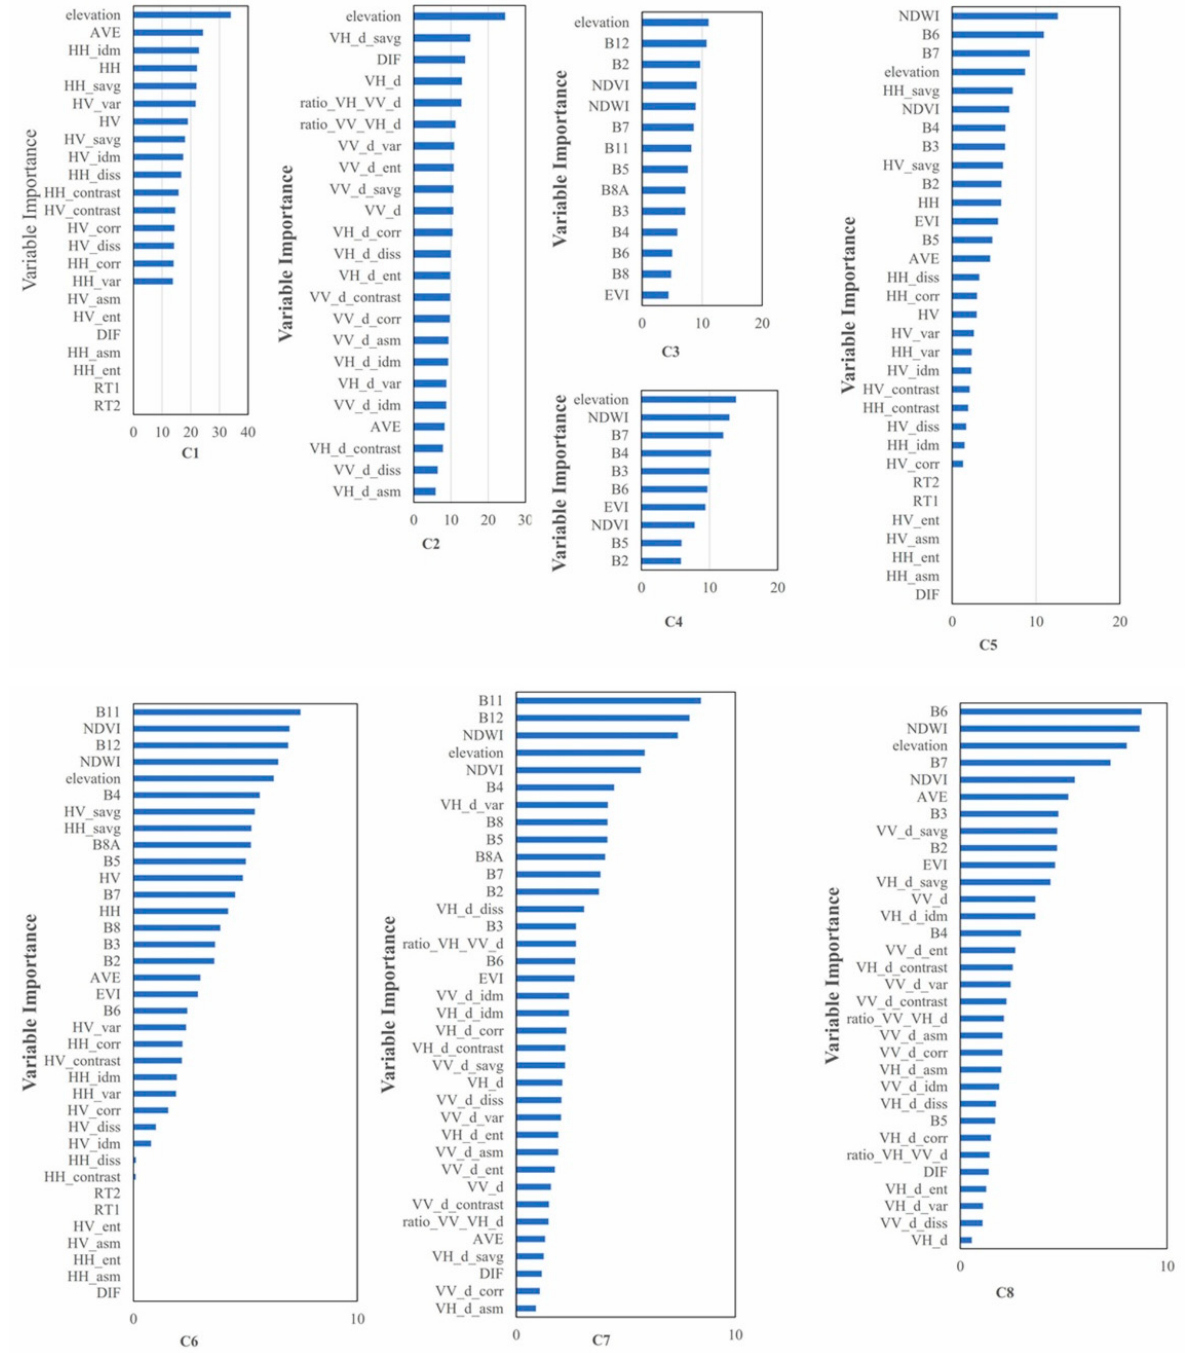
Figure 6. Random forest (RF) variable importance in eight combinations.